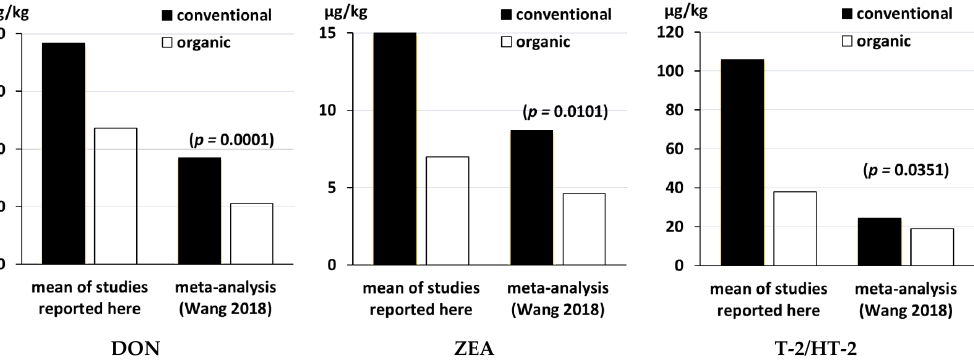
Figure 1. Mean deoxynivalenol ( DON ), zearalenone ( ZEA ), and T-2/HT-2 toxin ( T-2/HT-2 ) concen- trations found in the field-experiment- and farm-survey-based studies reviewed here (see Tables 1–3) and in a recent systematic review and meta-analyses of data from field-experiment-, farm-survey- , and retail-survey-based studies carried out by Wang (2018) [46]. Table 2 summarises results from studies that compared ZEA concentrations in or- ganic and conventional small grain cereals, and all seven studies available were on wheat. Three studies found a significantly lower concentration of ZEA in organic wheat, and three did not find a statistically significant difference. One study reported significantly higher ZEA concentrations in organically produced wheat, and this is the same study car- ried out in Germany in 1991 that also reported higher DON levels in organic rye [44]. Table 2. Results from field-experiment- and farm-survey-based studies that compared zearalenone (ZEA) concentrations in organically (org) and conventionally (con) produced cereal grain. Study Type Cereal Species Country